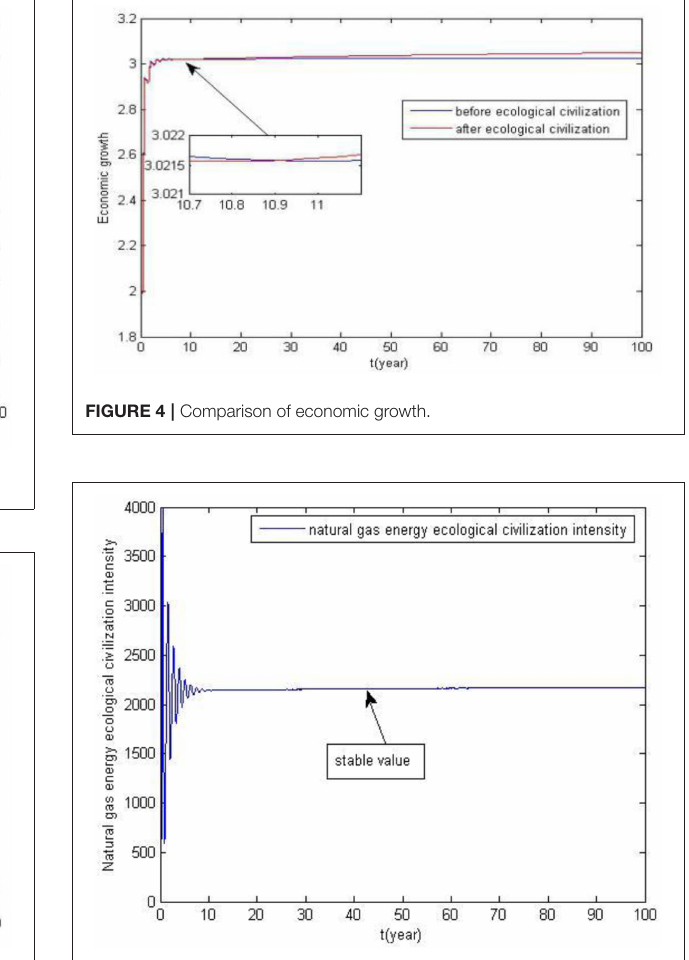
FIGURE 3 | Comparison of natural gas energy intensity.